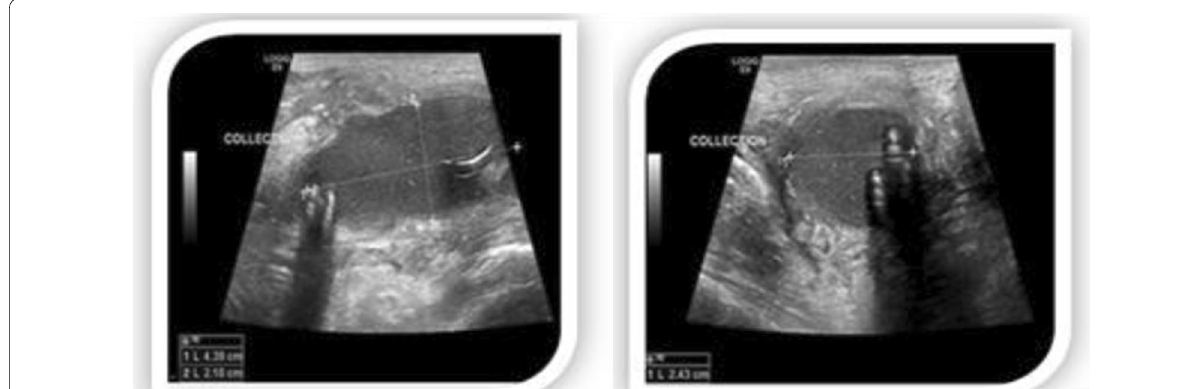
Fig. 3 Ultrasound picture showing collection around the reservoir